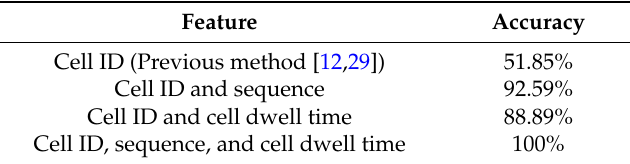
Table 3. The comparisons of the proposed method with different features for vehicle